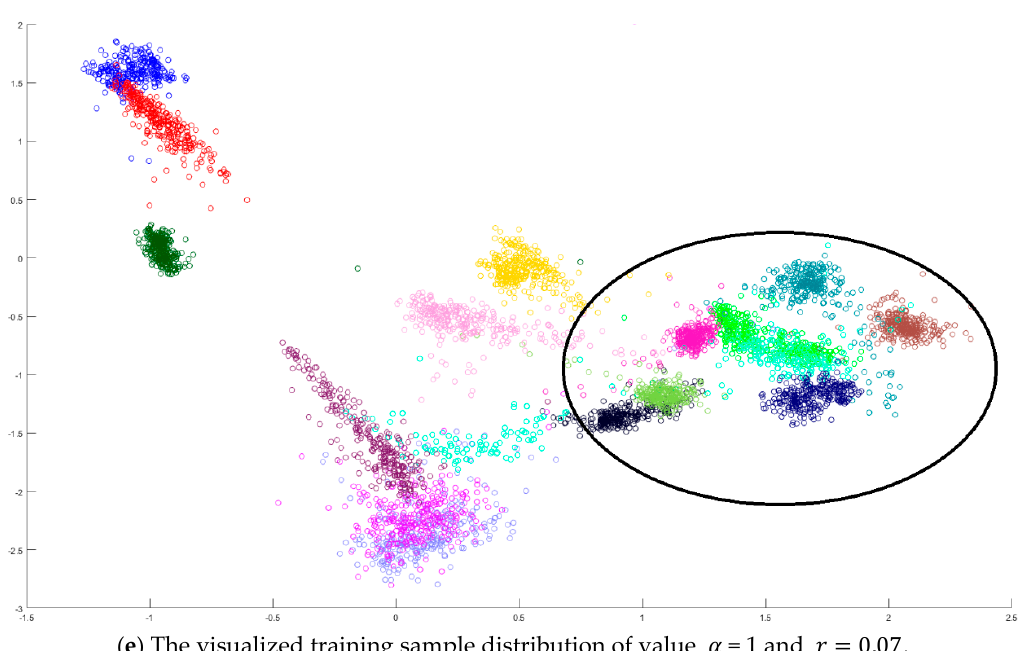
Figure 4. The analysis for the training data in dataset Salinas: ( a ) The overlapping degrees of various values α , ( b ) The visualized training sample distribution of PCA and r = 0.41, ( c ) The visualized training sample distribution of value α = 0 and r = 0.34, ( d ) The visualized training sample distribution of value α = 0.95 and r = 0.18, and ( e ) The visualized training sample distribution of value 𝛼 = 1 and 𝑟 (cid:3404) 0.07 .